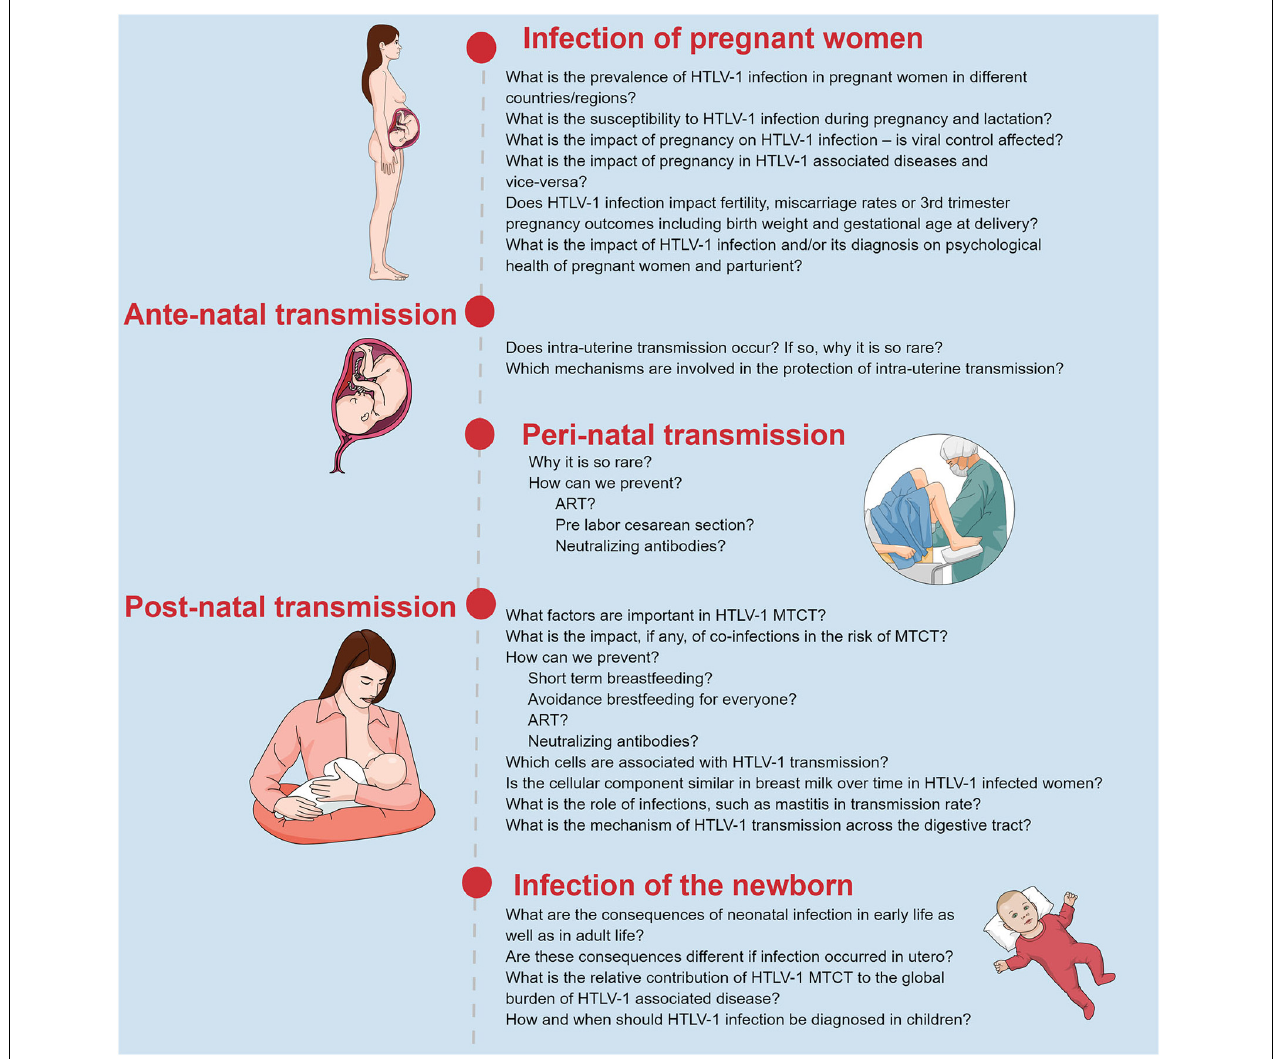
FIGURE 4 | Summary of unmet questions regarding HTLV-1 mother to child transmission. Original figure created with mindthegraph.